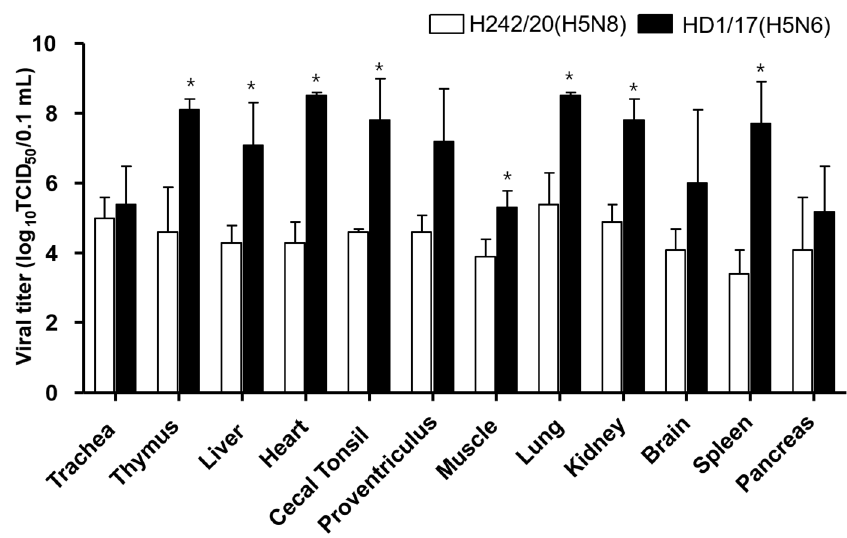
Figure 2. Virus titer of H242/20(H5N8) virus and HD1/17(H5N6) virus in various organs from SPF chickens which were inoculated intranasally with a viral dose of 10 6 EID 50 . H242/20(H5N8) and HD1/17(H5N6) virus infected organ tissues were collected at 3 dpi. The virus titers of the organ tissues (10% homogenates) were measured in chicken embryo fibroblast cell (DF-1). Data shown indicate the average of calculable positive organ titer. *; p < 0.05.